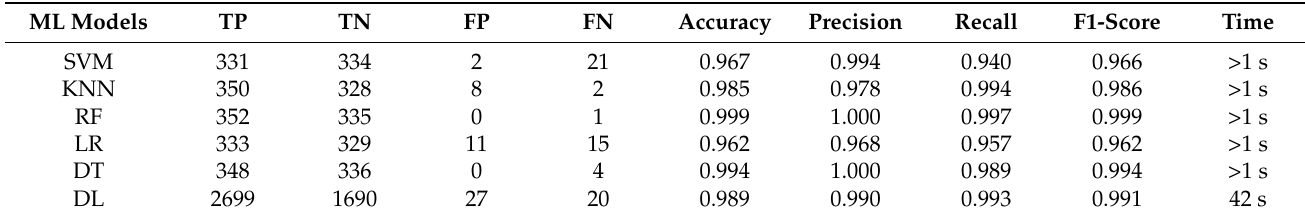
Figure 7. ROC curve for the RF model. Table 3. Results of performance the different models for data 2009–2014.